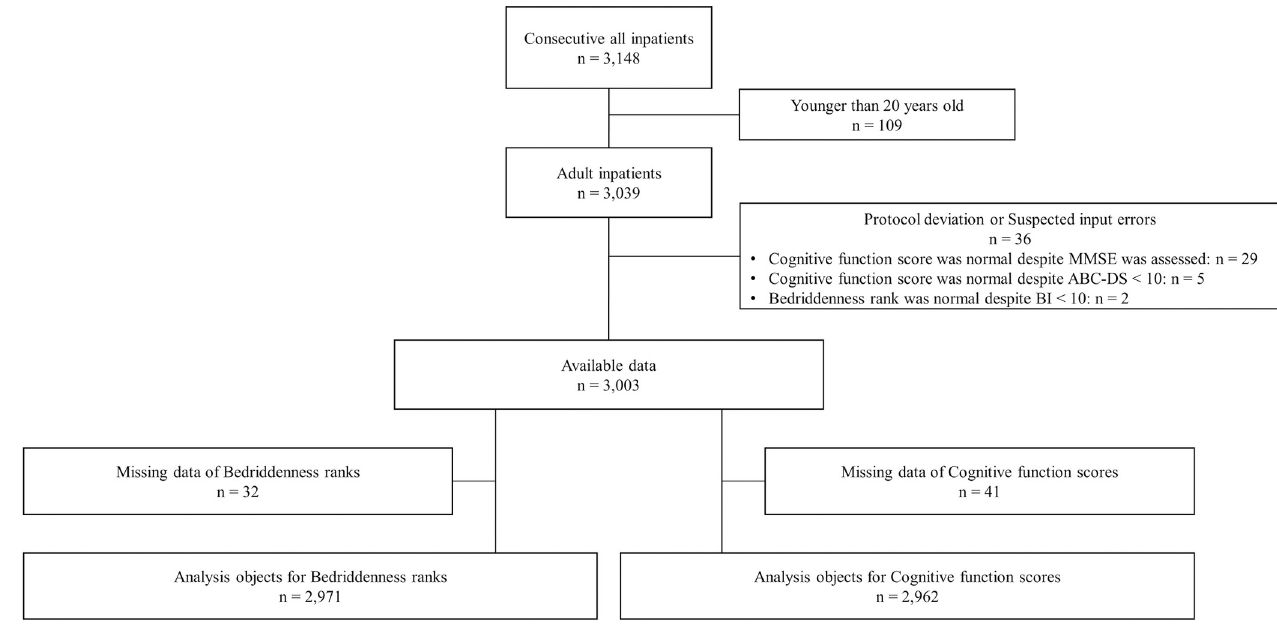
Fig 1. Data flow